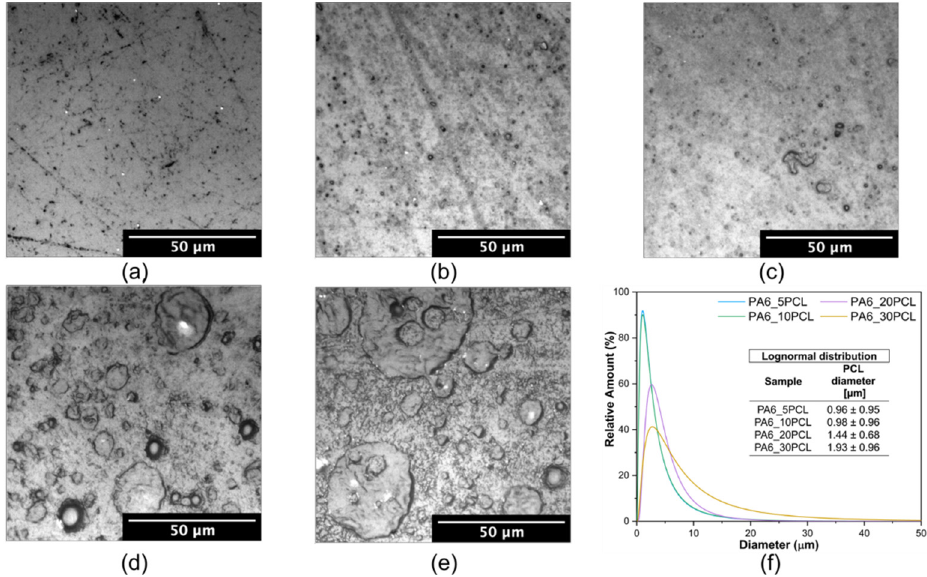
Figure 4. LM micrographs of the prepared PA6/PCL blends. ( a ) PA6, ( b ) PA6_5PCL, ( c ) PA6_10 PCL, ( d ) PA6_20 PCL, ( e ) PA6_30PCL, and ( f ) lognormal distribution of the diameters of the PCL domains in the